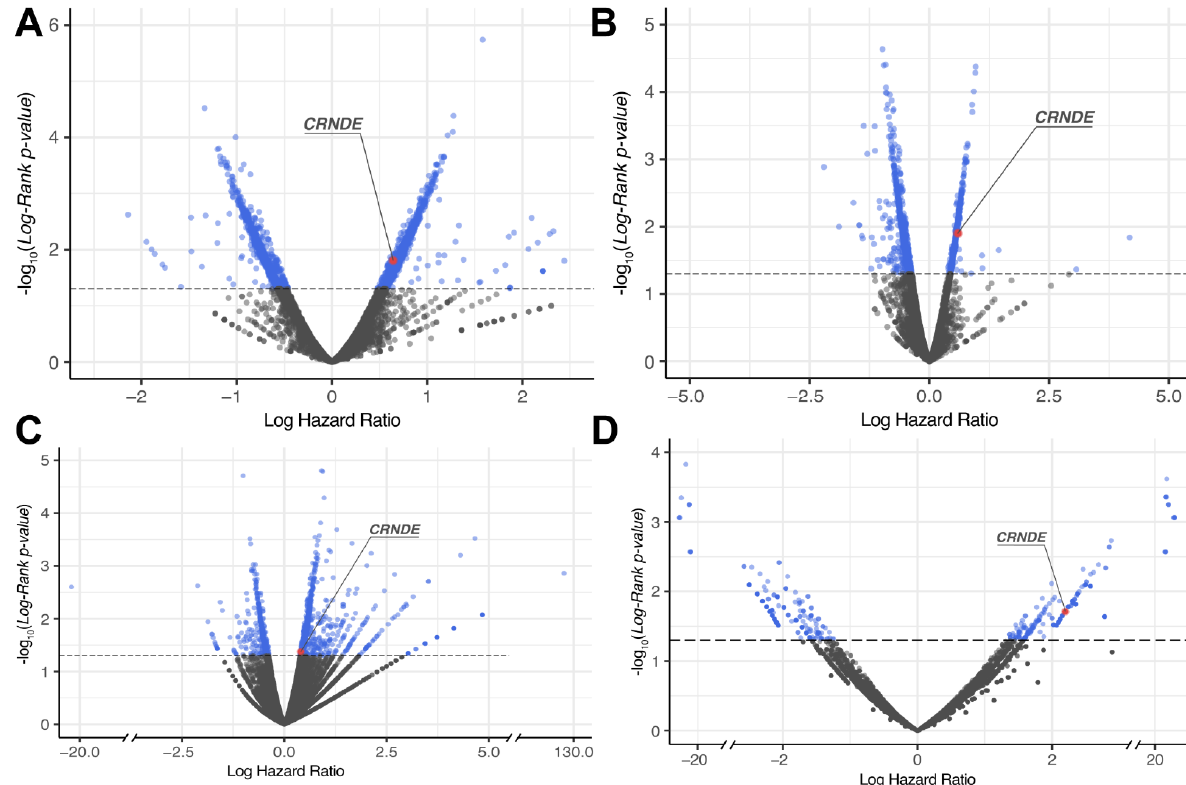
Figure 2. Distribution of differential genes by log-rank p -value and log hazard ratio for overall survival (OS) data across: ( A ) CGGA_325, ( B ) CGGA_693, ( C ) TCGA and ( D ) Slovenia glioblastoma datasets.